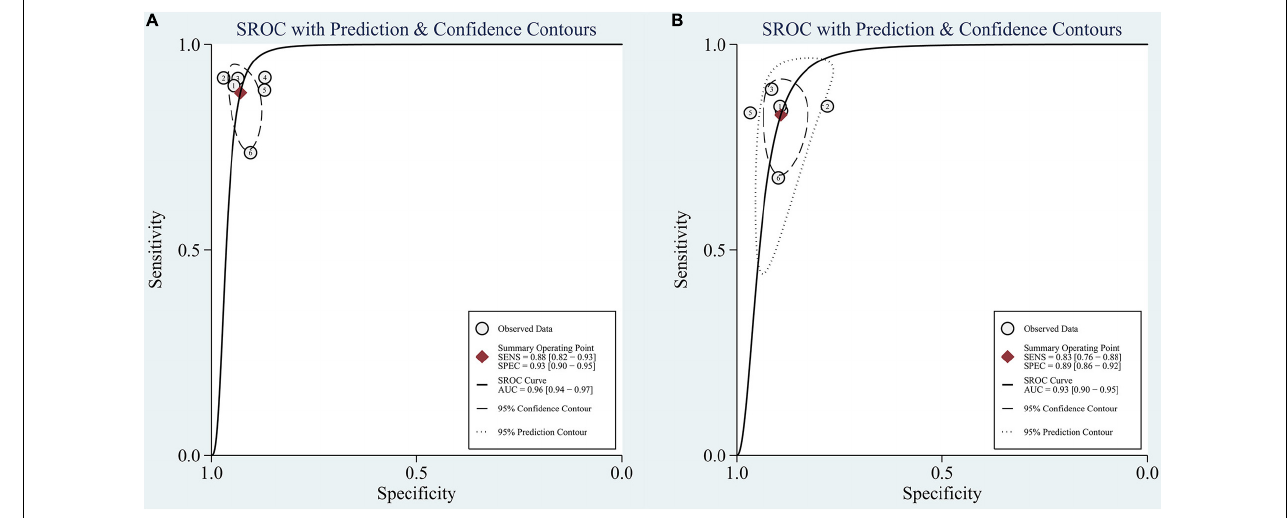
FIGURE 6 | SROC curve for the task of AD vs. CN classification: (A) SROC curve for the GAN group and (B) SROC curve for the non-GAN group.